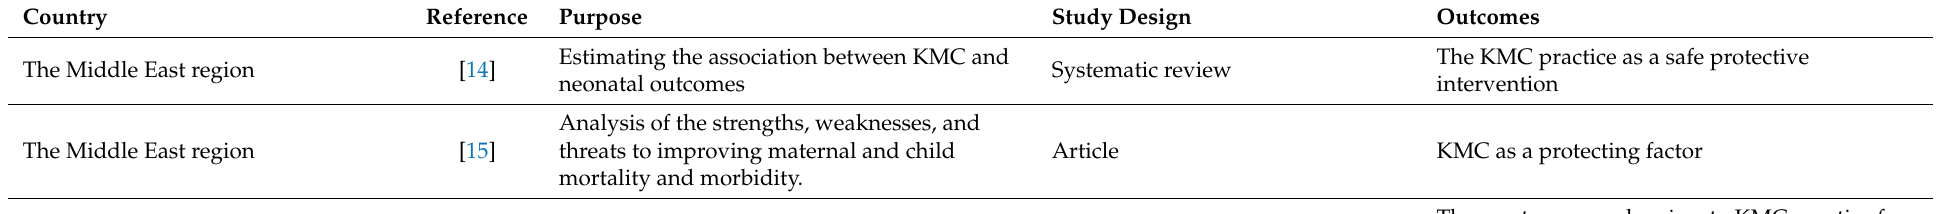
Table 2. Research on KMC (skin to skin) in the Middle